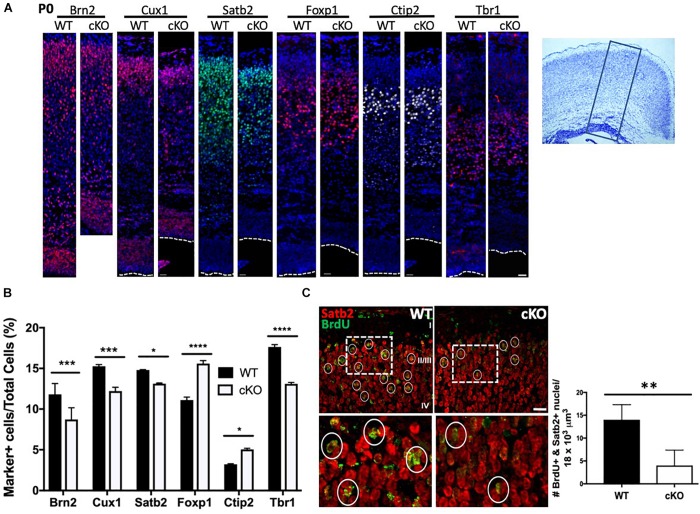
Reduced production of upper layer cortical neurons in Snf2h cKO mice. (A) Cortical sections from P0 brains were immunostained with antibodies to UL (layers II-IV, Brn2, Cux1, Satb2, and Foxp1) and DL (layers V-VI, Ctip2 and Tbr1) neurons, as indicated. Dotted lines indicate the position of the lateral ventricle. Box on cresyl violet stained section (rightmost panel) indicates the approximate position of the images shown on the left panels. Scale bar, 20 μm. (B) Cortical marker positive cells were plotted as a percentage of the total number of DAPI+ cells contained within a box of fixed width that contained all cells starting from the pial surface to the lateral ventricle. Values are presented as the mean ± SEM. ∗P < 0.05, ∗∗∗P < 0.01, ****P < 0.001, Student’s t-test, n = 4–6 mice per genotype. (C) UL neurons were birthdated with a single injection of BrdU at E15.5 and harvested at birth for co-immunostaining with Satb2 (red) and BrdU (green). Dotted boxes indicate the position of the higher magnification images shown below. Circles denote BrdU+ nuclei. Graph depicts quantitation of BrdU+ (>75% of nucleus stained for BrdU) and Satb2+ neurons from E15.5 mutant and control embryos. Five cubic bins were scored and averaged per embryo. Values are presented as the mean ± SEM. ∗∗P < 0.05, Student’s t-test, n = 3 mice per genotype.